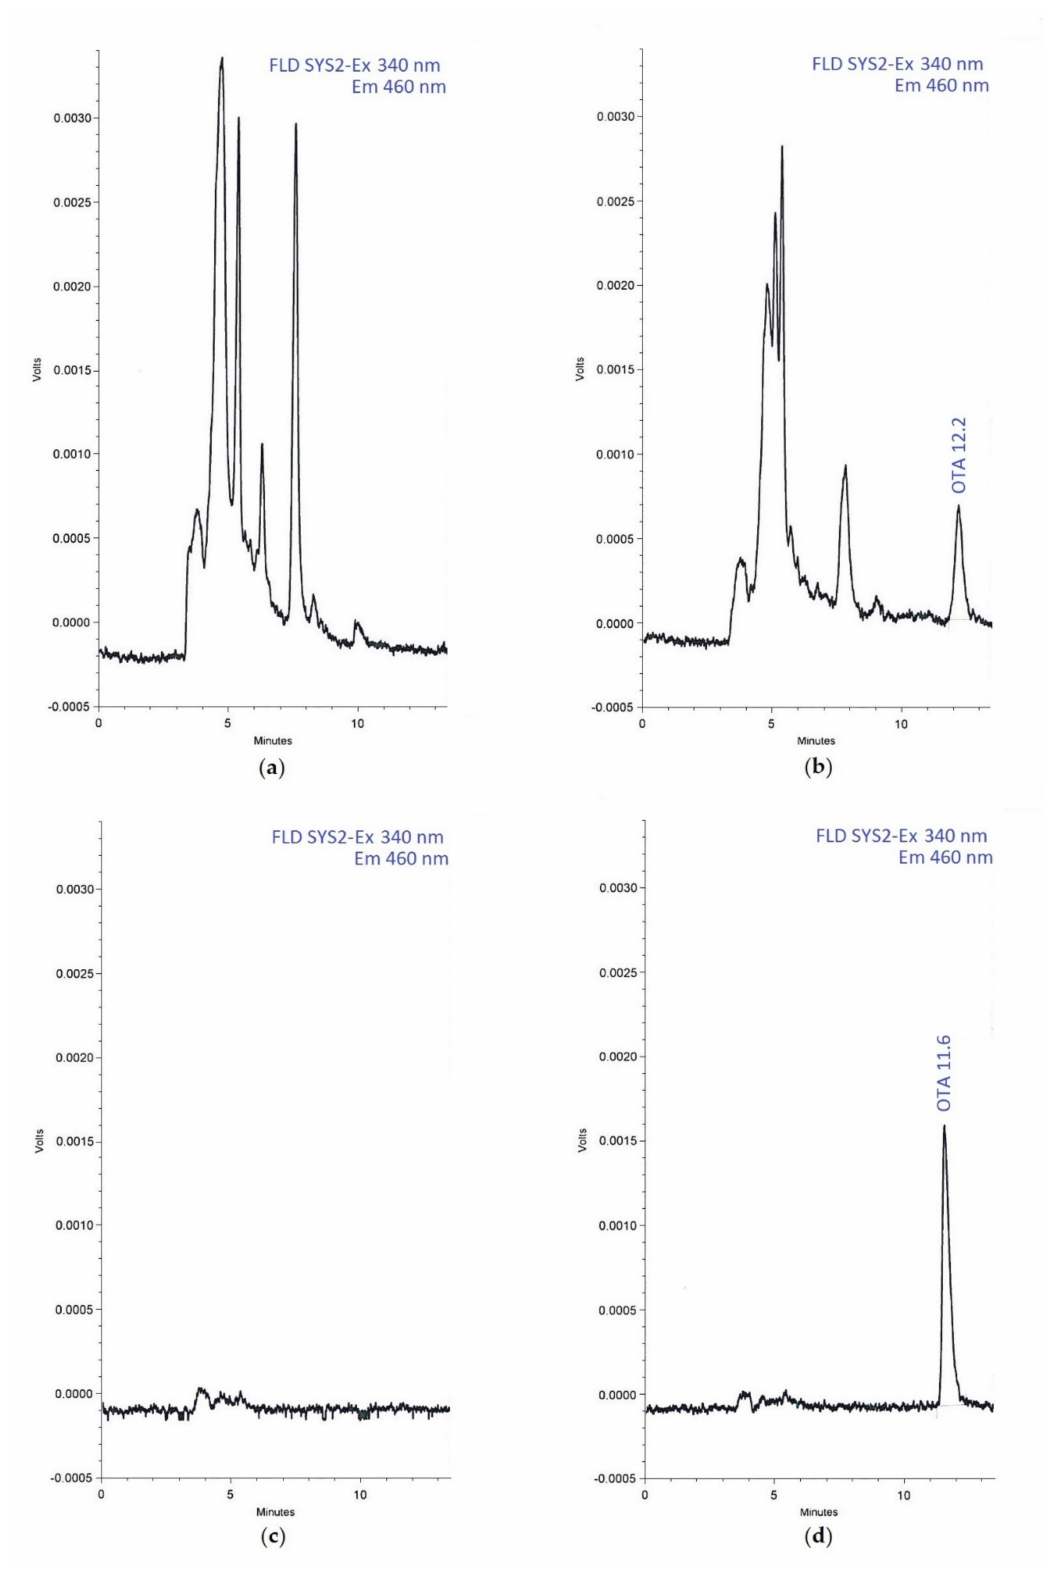
Figure 1. Chromatograms of a blank sample of bile ( a ), a naturally contaminated sample of bile at 13.09 µ g / L level ( b ), a blank sample of kidney ( c ), a blank sample of kidney spiked with OTA at 1.5 µ g / kg level ( d